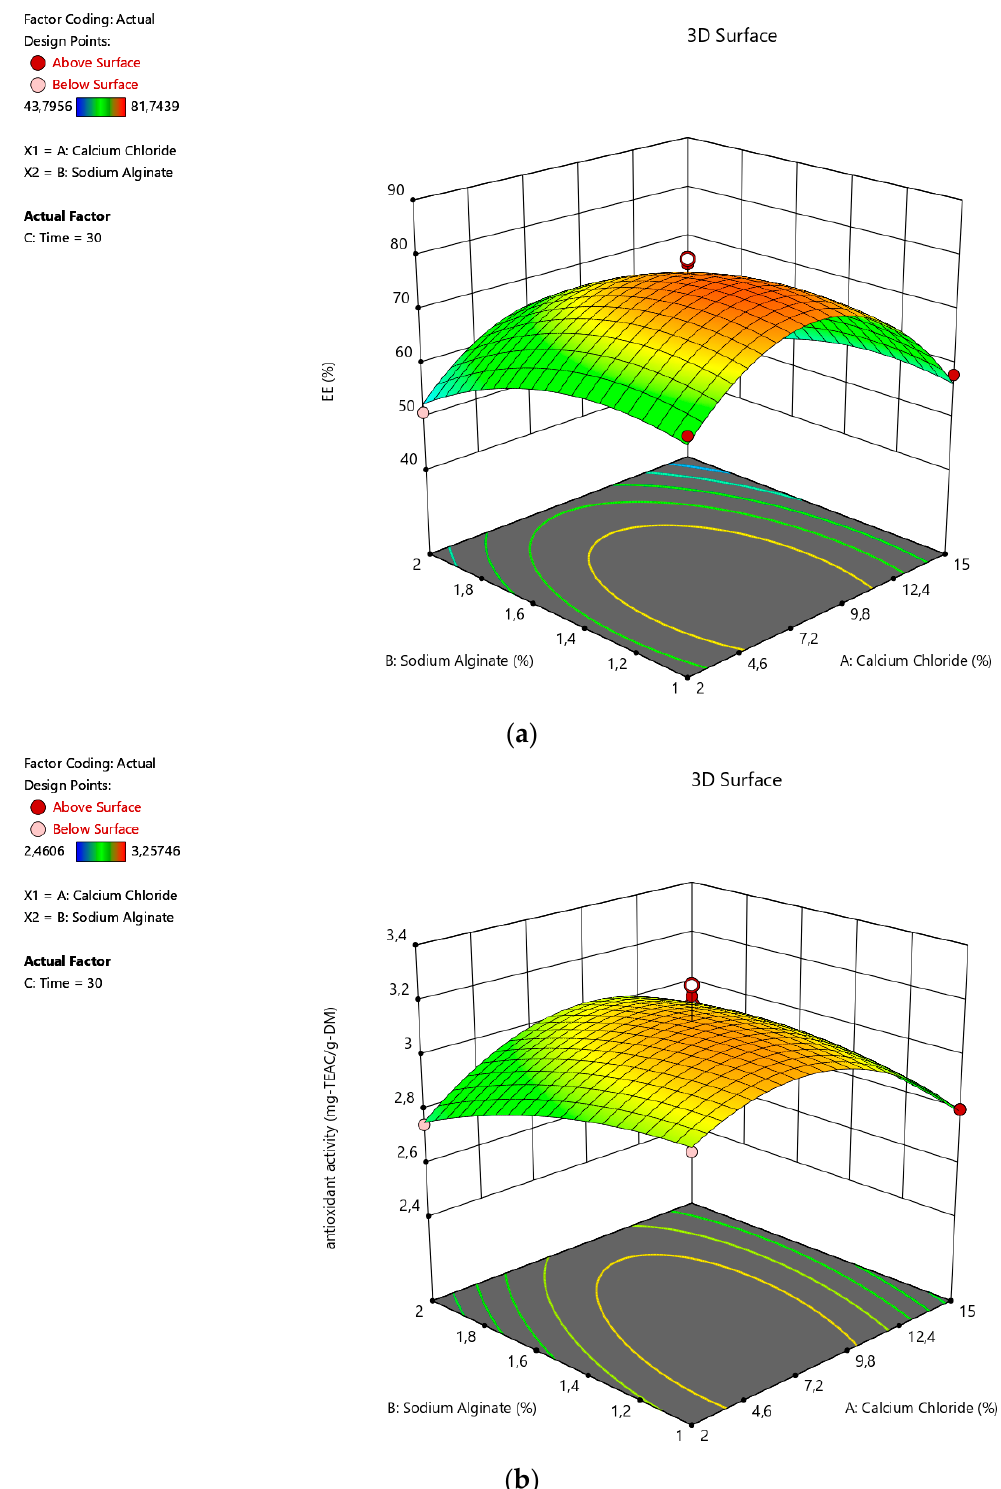
Figure 1. Effects of calcium chloride concentration to alginate concentration on the ( a ) encapsulation efficiency and ( b ) antioxidant activity of the alginate microcapsules containing the active substances from sour cherry peel